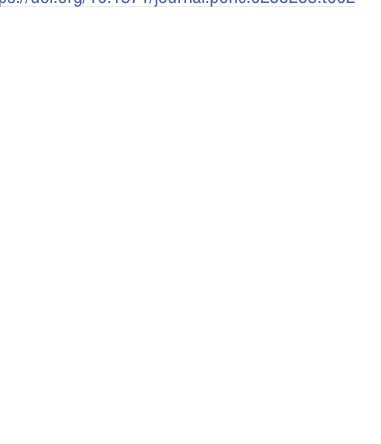
Inflammatory Response (AIR) score, and Adult Appendicitis Score (AAS) [8–10, 12, 13, 15]. The numbers of patients between uncomplicated and complicated appendicitis groups were contrasted by determining the risk scores of each patient using each model and then compar- ing the results (Table 3). Only AIR scores showed significance between the score and the exis- tence of complicated appendicitis ( p = 0.026). In addition, two scoring models for the prediction of complicated appendicitis were also tested. Atema score and Imaoka score both showed significance between the score and the existence of complicated appendicitis ( p < 0.001).